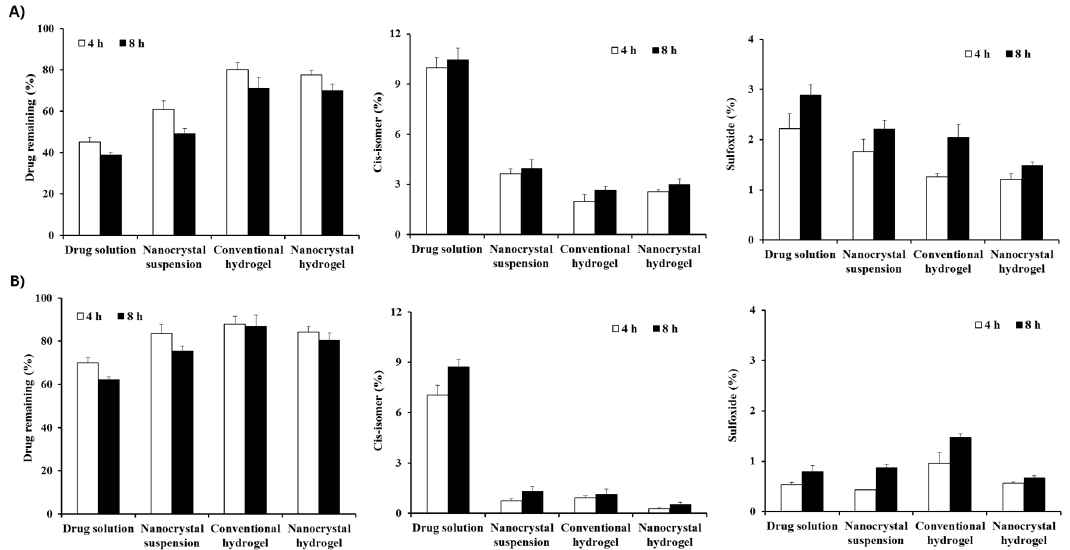
Figure 4. Drug remaining, and formation of cis -isomer and sulfoxide in the MTK nanocrystal or conventional formulations under light exposure, ( A ) in the absence of Sunset Yellow FCF and ( B ) in the presence of the photo-stabilizer. The data is represented as mean ± SD ( n =